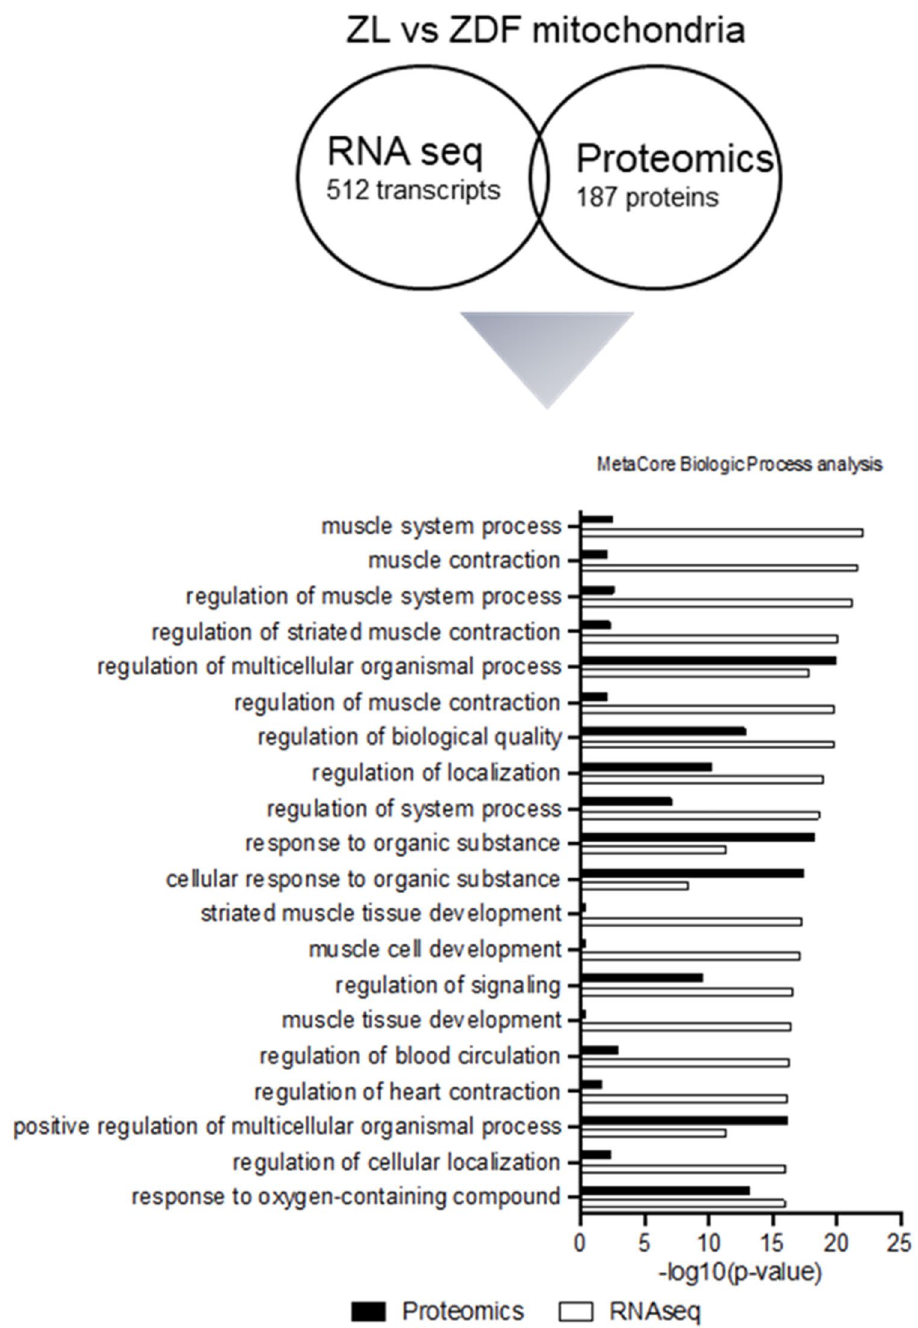
Figure 10. Non-diabetic mitochondrial transplantation transcriptomic changes are consistent with proteomic alterations. Gene ontology-based comparison of RNA-seq (black) and proteomic data (white) using MetaCore in hearts receiving diabetic ZDF- or non-diabetic ZL-mitochondrial transplantation as compared to hearts receiving vehicle